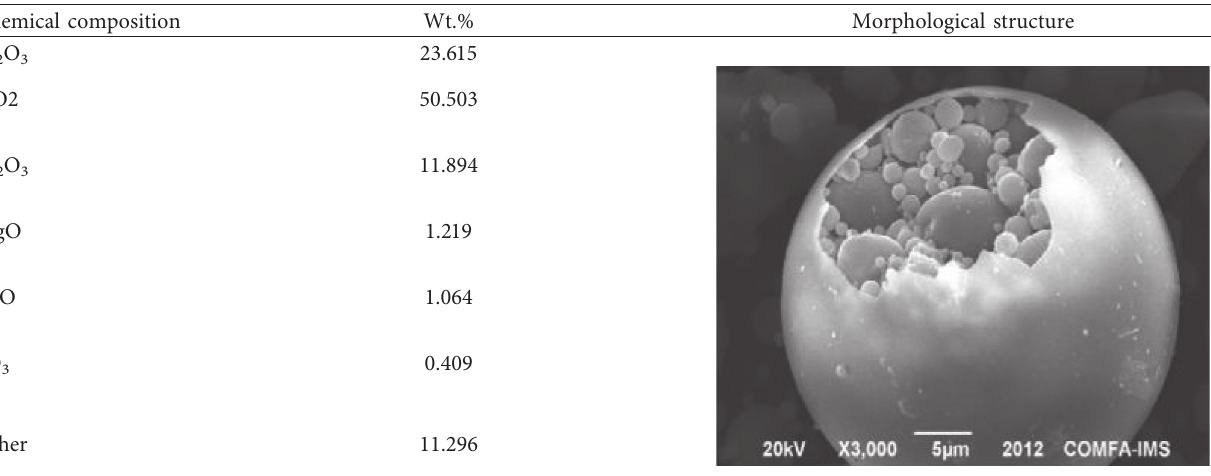
Table 2: Chemical composition and morphological structure of fly ash [26].